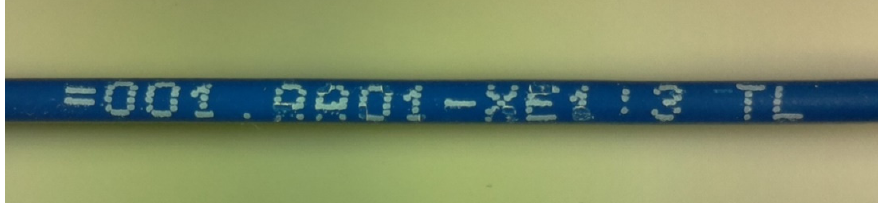
Figure 9. The actual picture taken by the WLR: clear, readable text; dotted font not visible (blurred).